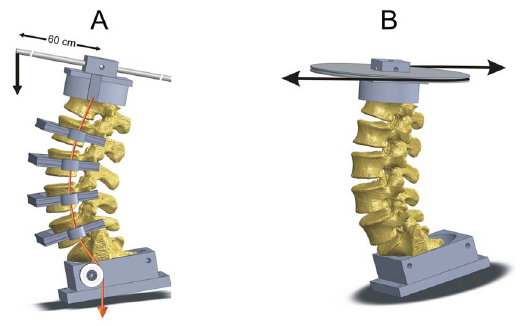
Figure 1. Schematic of the loading apparatus for range of motion tests in flexion-extension and axial rotation. Testing for ROM in lateral bending was performed using an offset-loading arm in the frontal